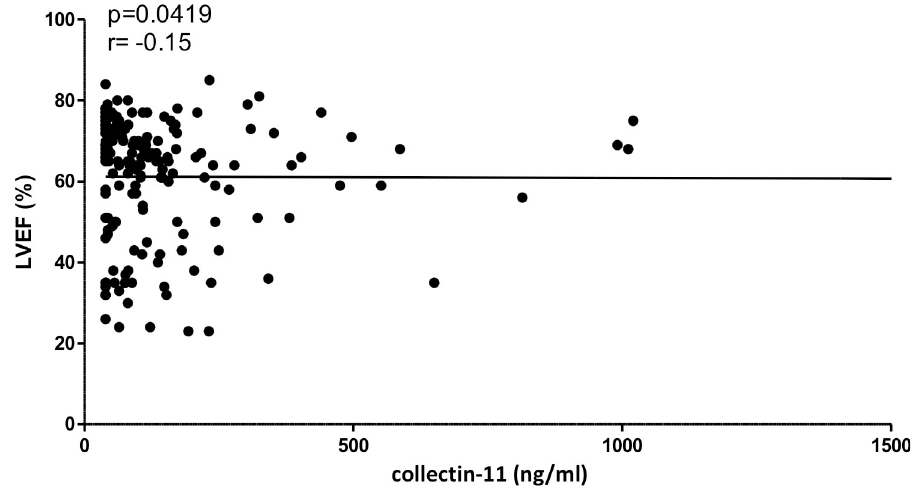
Fig 3. Correlation between collectin-11 plasma levels and LVEF index of chronic CD patients (n = 176).